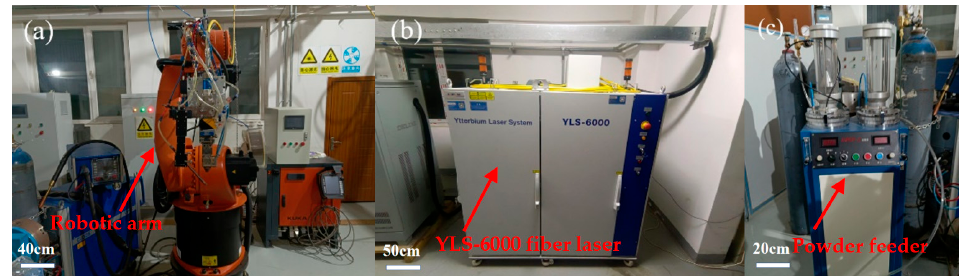
Figure 1. Laser cladding system: ( a ) KUKA robotic arm, ( b ) YLS-6000 fiber laser, and ( c ) powder feeder.